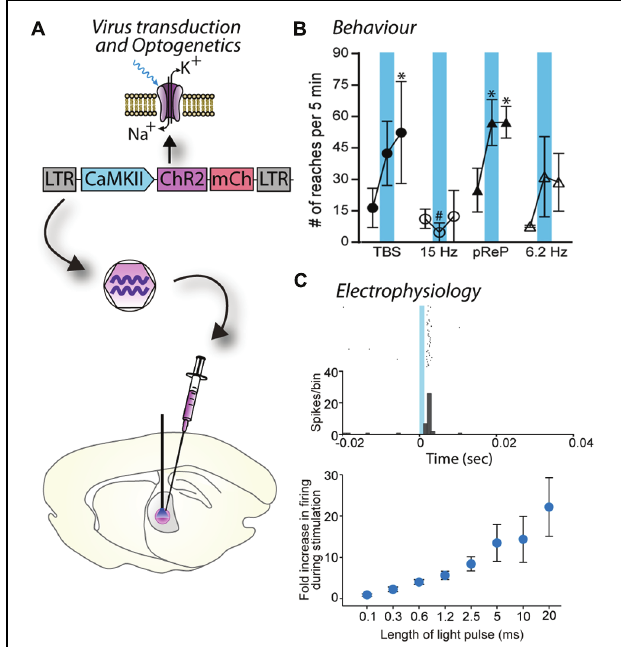
FIGURE 3 | Blue light stimulation of neurons expressing a channelrhodopsin alters cell activity and behavior. (A) A lentiviral vector (LV-CaMKII-ChR2-mCherry) was injected into the motor thalamus of rats to transduce glutamatergic neurons. Blue light stimulation of motor thalamus opened channelrhodopsin2 cation channels in the membrane of transduced neurons. (B) Effect of blue light stimulation of motor thalamus on movement performance in an acute model of parkinsonism. For each pattern, the number of reaches executed by rats is represented for 5 min before, during and after blue light (473 nm) stimulation. Theta burst stimulation (TBS) and the physiological reaching pattern (pReP) are irregular patterns and significantly increased reaching performance. Conversely, the equivalent tonic patterns (15 and 6.2 Hz, respectively) did not improve reaching. ∗ p < 0.05, versus prestimulation (Tukey’s test). # p < 0.05 versus pREP pattern (Tukey’s test). Reproduced with permission from Seeger-Armbruster et al. (2015). (C) A similar experiment performed with injection of LV-EF1 α -hChR2(H134R)-eYFP into ventrolateral motor thalamus of a rhesus monkey. Upper panel, data show the firing rate (spikes/bin) of one neuron before ( − 20–0 ms), during (0–1.2 ms), and after (1.2–40 ms) blue light stimulation (1.2 ms pulse). The cell responded with a brief increase of spiking activity just after the pulse of blue light. Bottom panel, the duration of blue light stimulation affected the responses of motor thalamus neurons; longer pulses caused larger increases in firing rate. Reproduced with permission from Galvan et al.